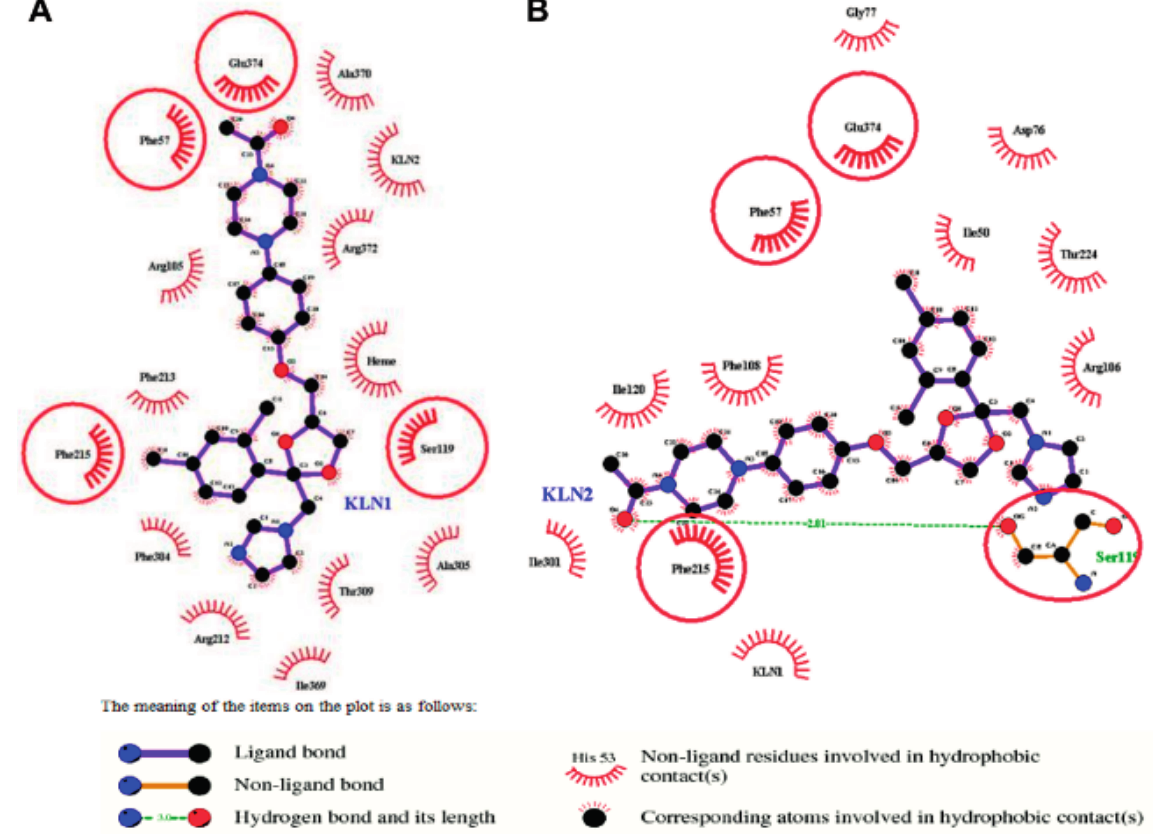
Figure 3. 2D-diagram of the detailed binding information for the ( A ) normal and ( B ) cooperative binding model of CYP3A4w structure. The first KLN binding in the active site was labeled as KLN1, and the second one as